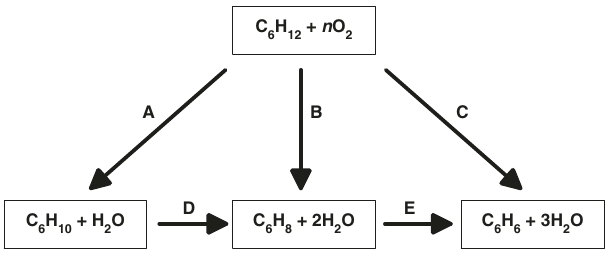
Fig. 1 Simpli fi ed reaction scheme of the ODH of